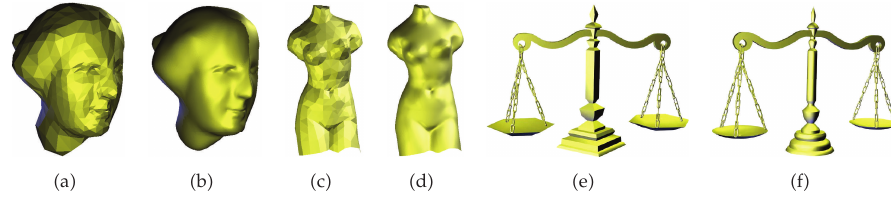
Figure 4: Loop-like subdivision examples.